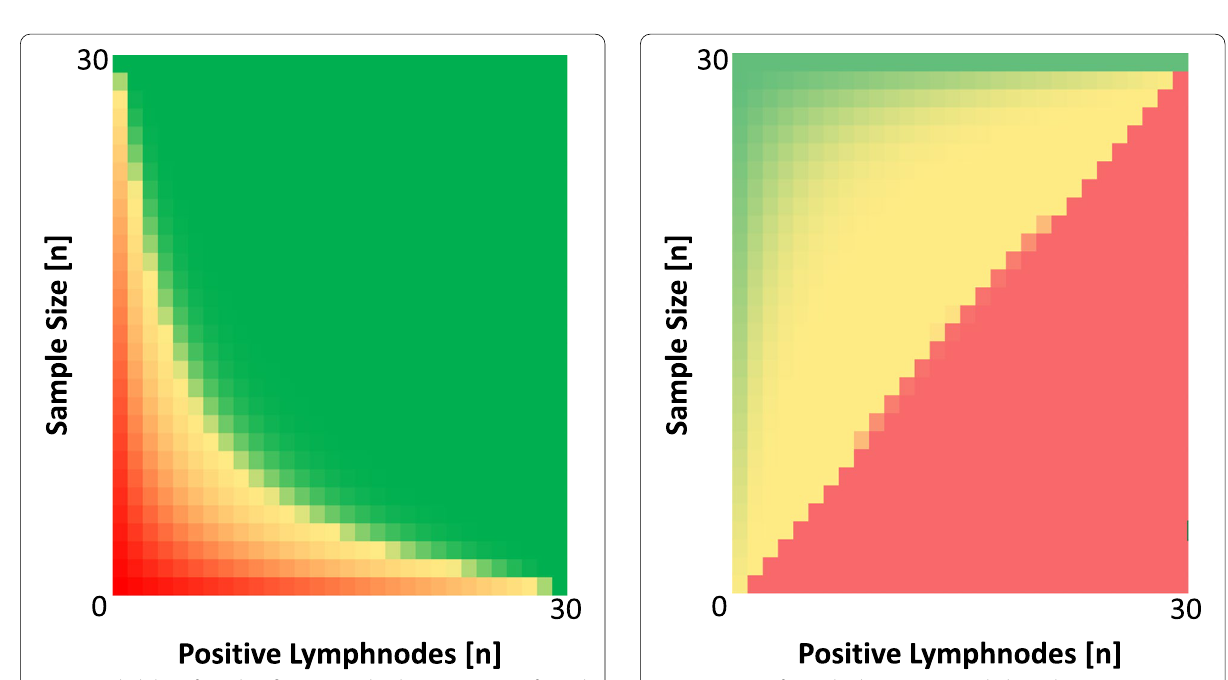
Fig. 2 Probability of misclassification. Under the assumption of equal distribution of positive lymph nodes in the sample, the probability for nodal negative classification is shown for any given number of positive lymph nodes and any given sample size. Green color: 0% probability; red color: 100% misclassification